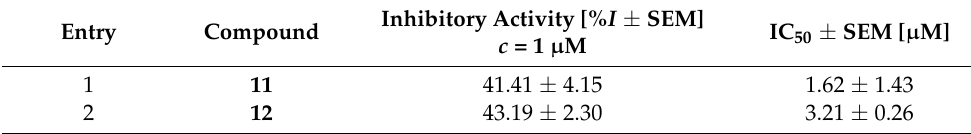
Table 1. Inhibitory activities of compounds 11 and 12.